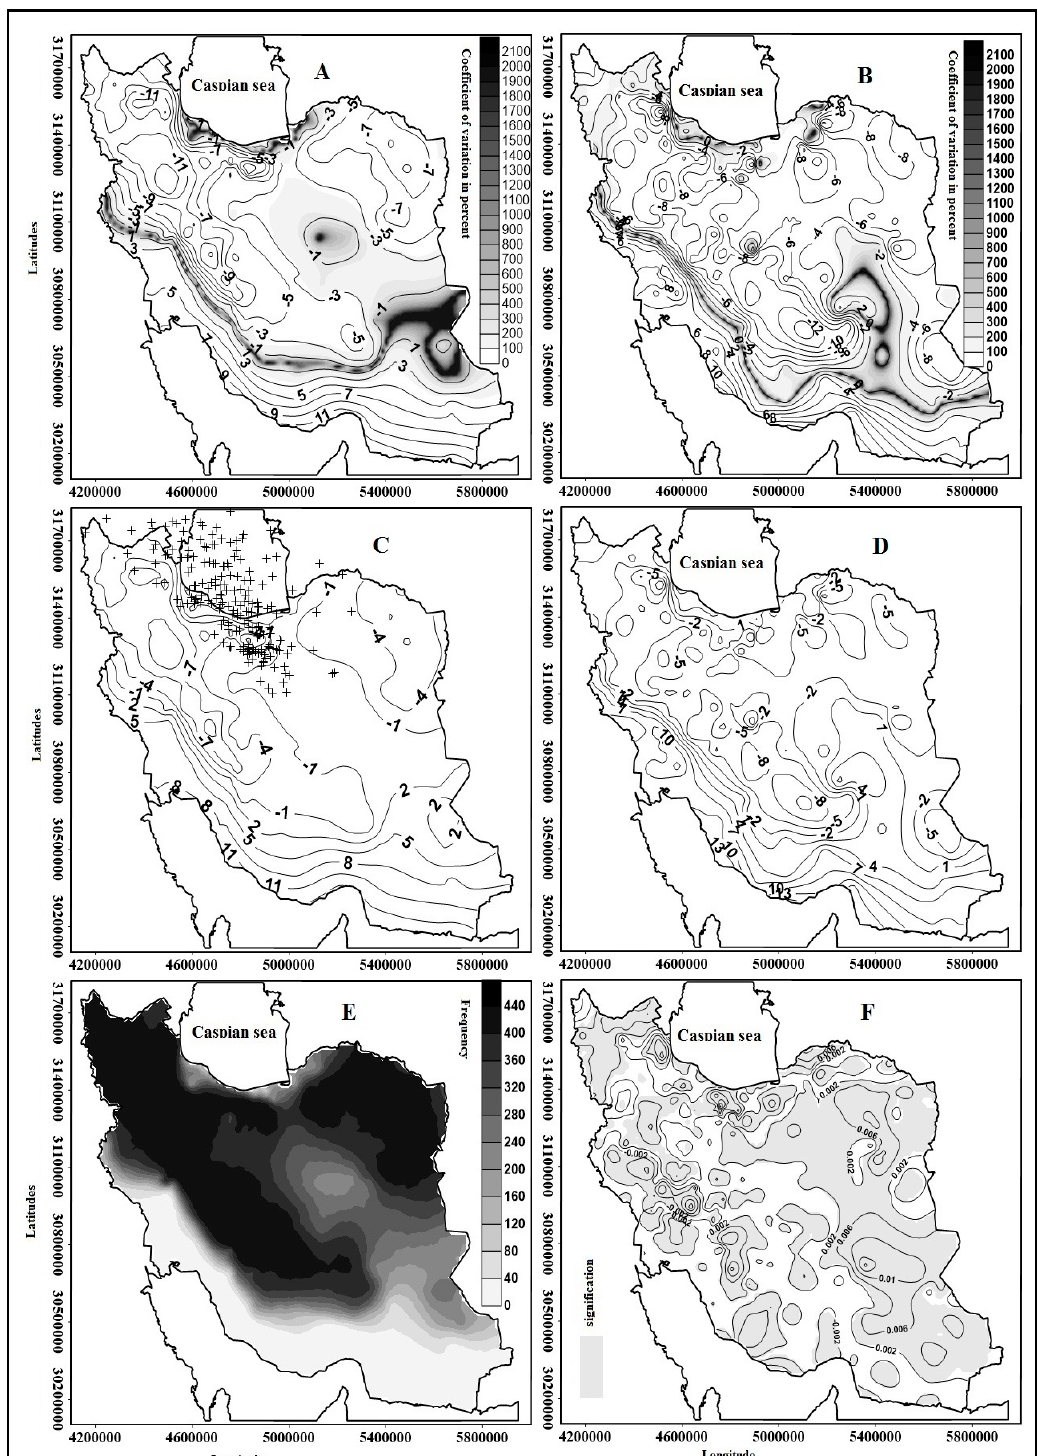
Figure 10. The fourth pattern; ( A ) Spatial distribution of temperature average and coefficient of variation for the whole group; ( B ) spatial distribution of temperature average and coefficient of variation for the representative day; ( C ) anomalies and center of masses for the whole group; ( D ) anomalies for the representative day; ( E ) frequency of frosts for the whole group; and ( F ) spatial distribution of the trend of Iran’s frosts for the whole group.